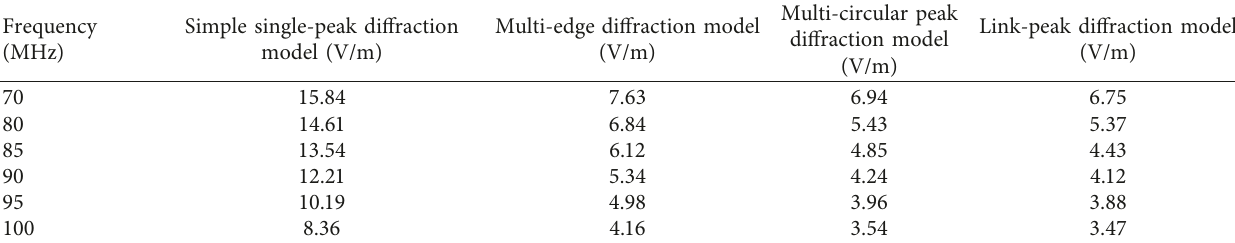
Table 2: Simulation experiment